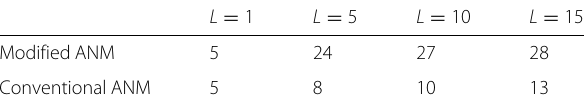
Table 1 Critical sparsity performance comparison of modified ANM and conventional ANM L = 1 L = 5 L = 10 L = 15 Modified ANM 5 24 Conventional